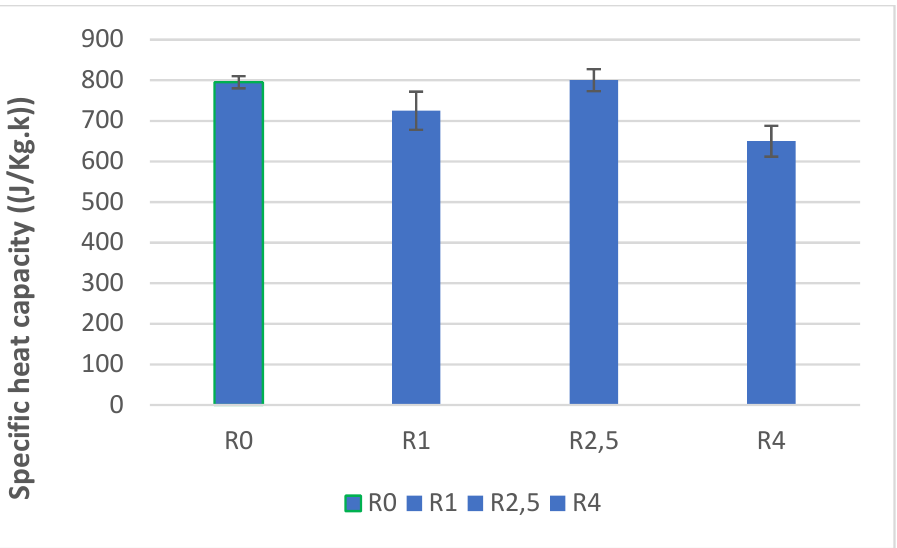
Figure 10. The variation of the specific heat capacity of cob as a function of Sargassum muticum content. With the increasing body soil matrix porosity, the cob’s insulating capacity